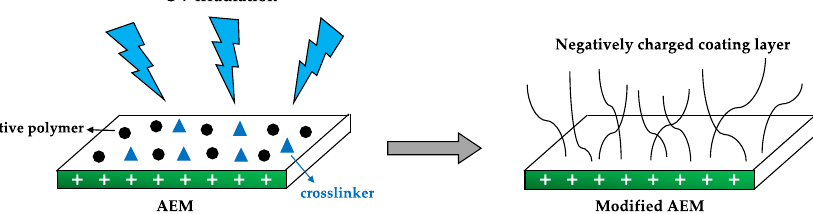
Figure 3. Illustrative description of a surface graft polymerization method via UV irradiation, using an active polymer (polyanion) and a crosslinking agent to create a negatively charged coating layer to the surface of an anion exchange membrane (AEM).